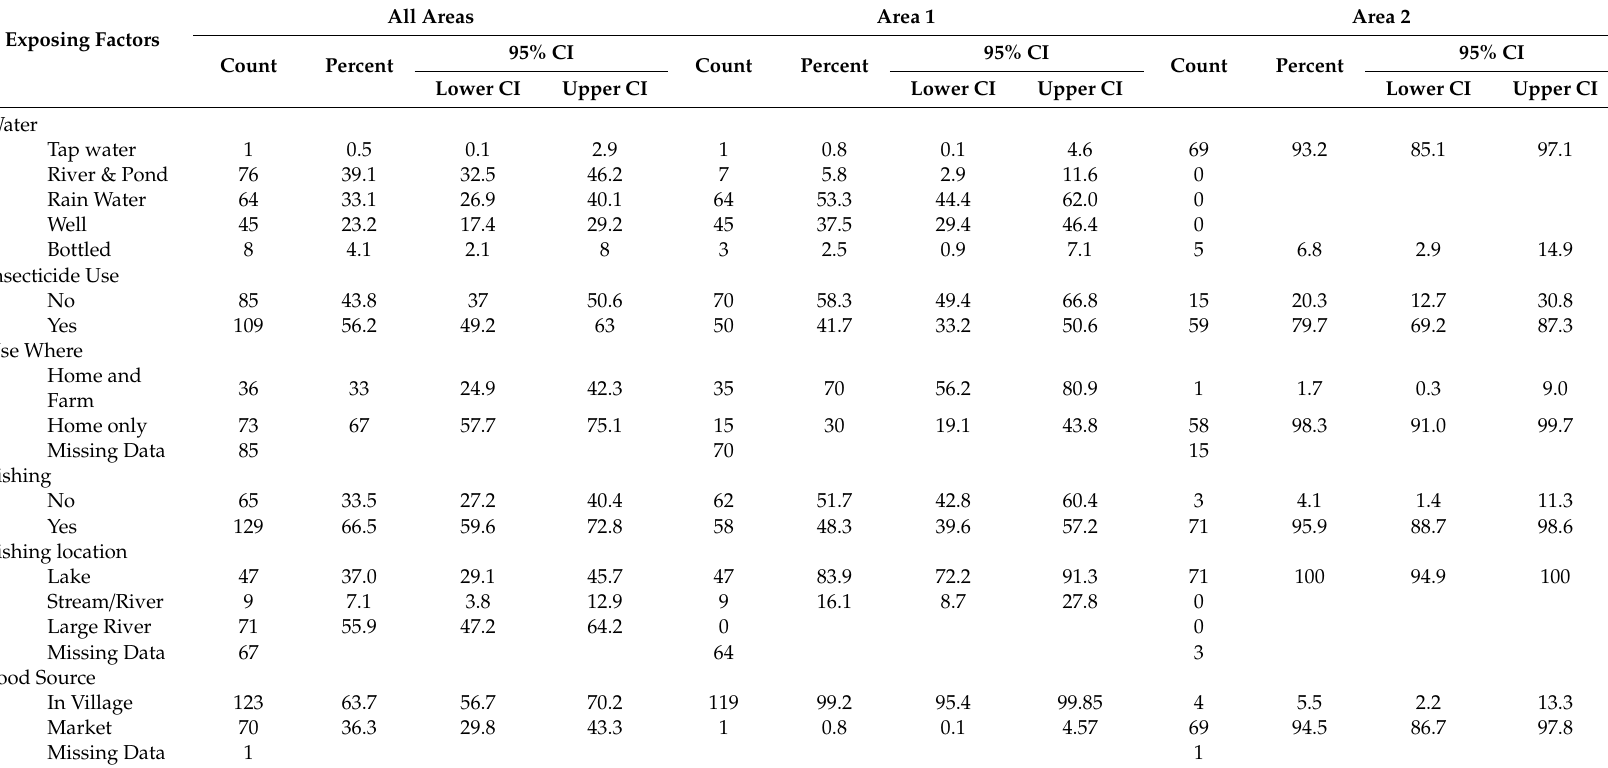
Table 3. Toxic exposing factors from the study areas. Results presented in percentages with 95% Confidence